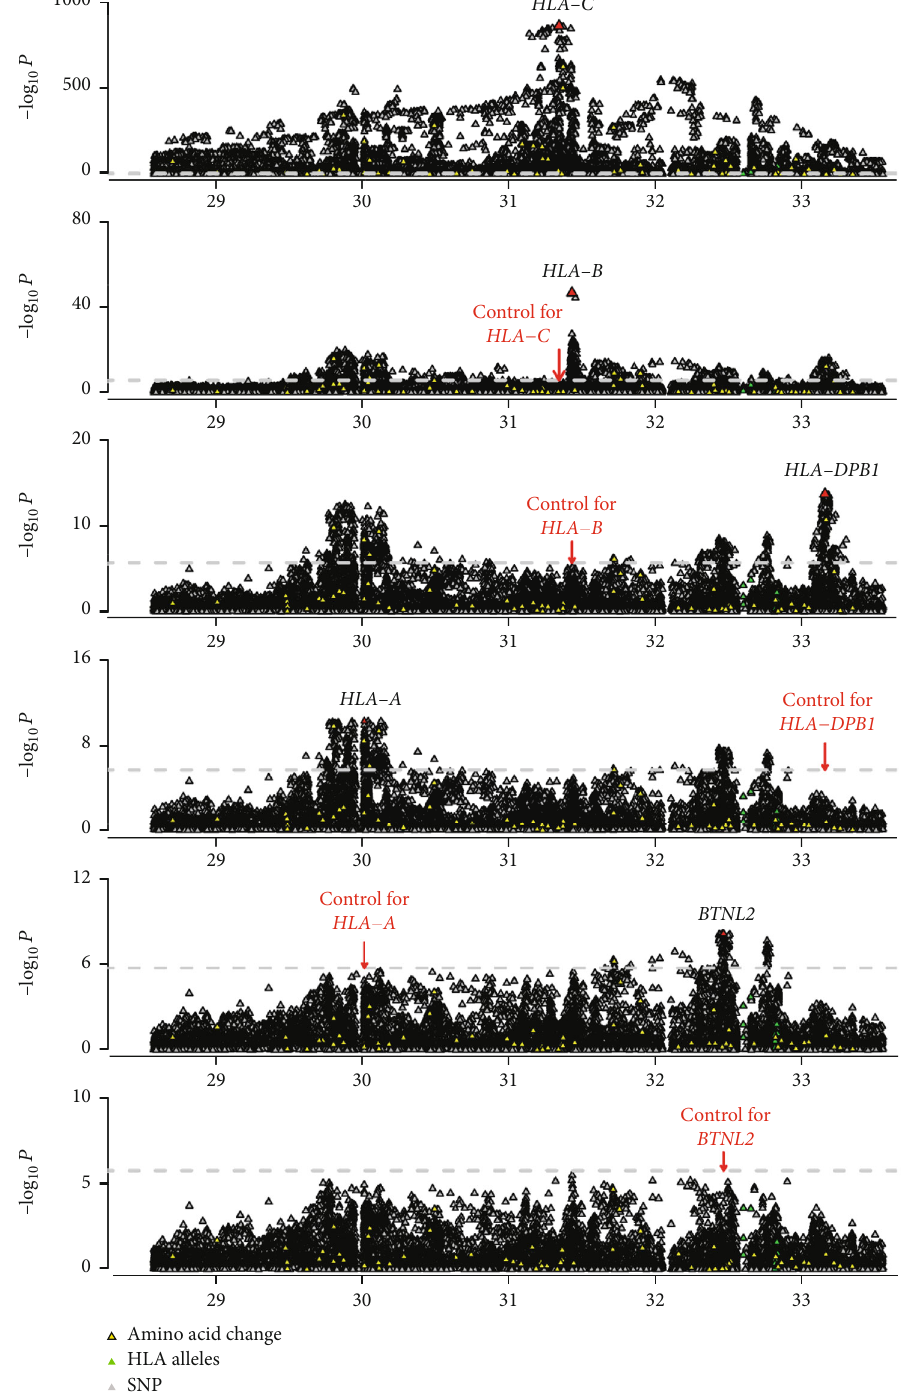
Figure 2: A Manhattan plot of the stepwise conditional association for SP in the MHC region. Stepwise analysis of HLA-C , HLA-B , HLA-DPB1 , HLA-A , and BTNL2 in SP vs. control. For each plot, the horizontal axis shows the genomic position and the vertical axis shows the negative log -transformed P values for the association. The dashed horizontal line corresponds to the signi fi cance 10 threshold of P = 1 : 87 × 10 − 6 . The red triangles represent the top associated